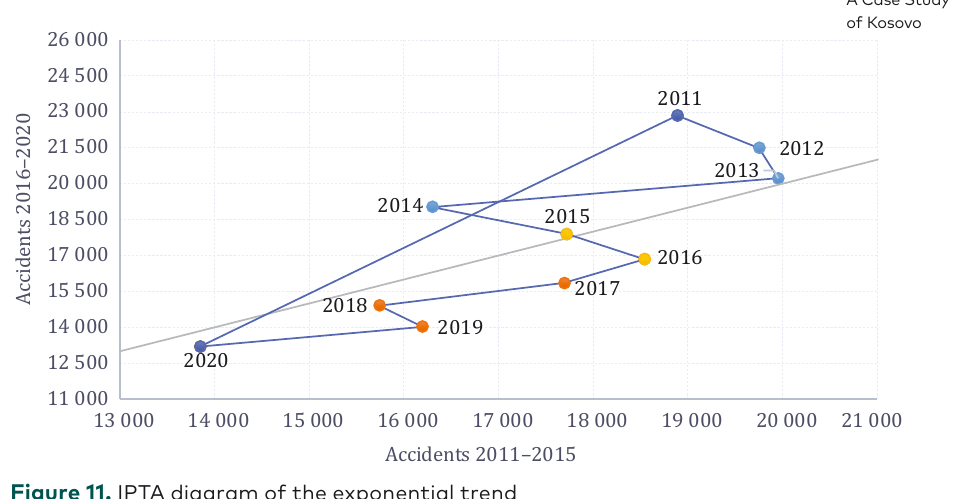
Figure 11. IPTA diagram of the exponential trend